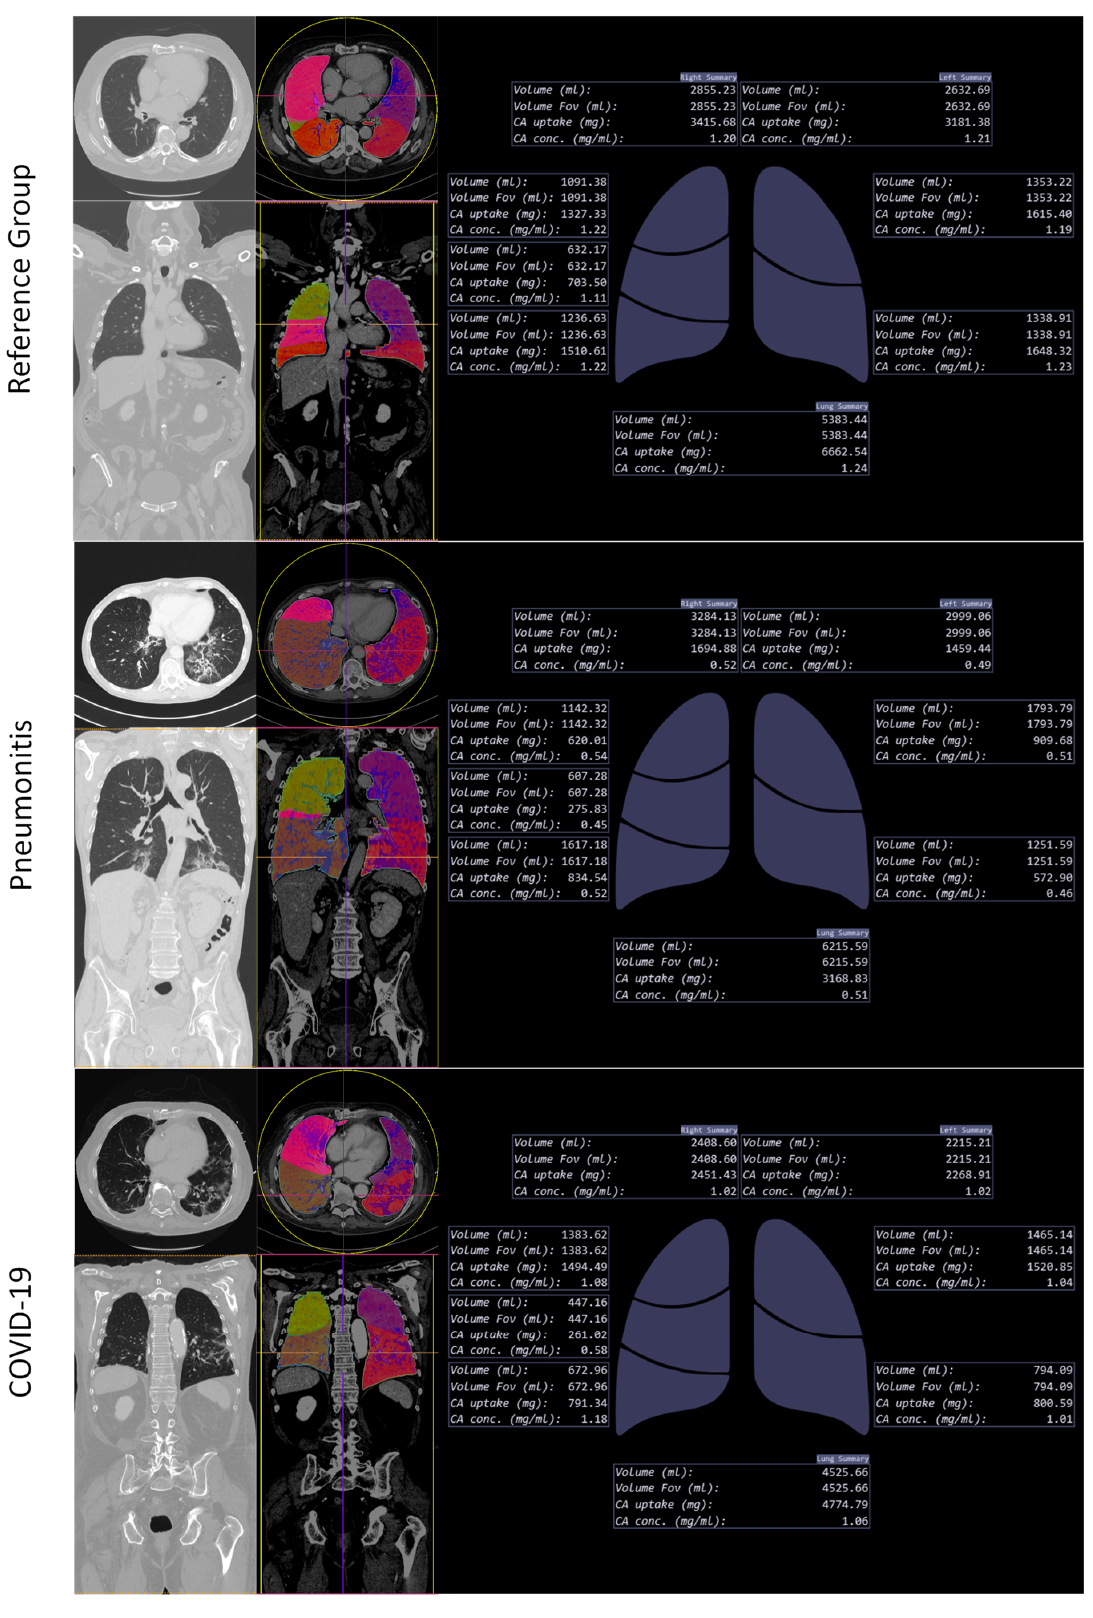
Figure 4. AI DECT lung segmentation and analysis in three patients (Reference, Pneumonitis, and COVID-19 with similar findings).